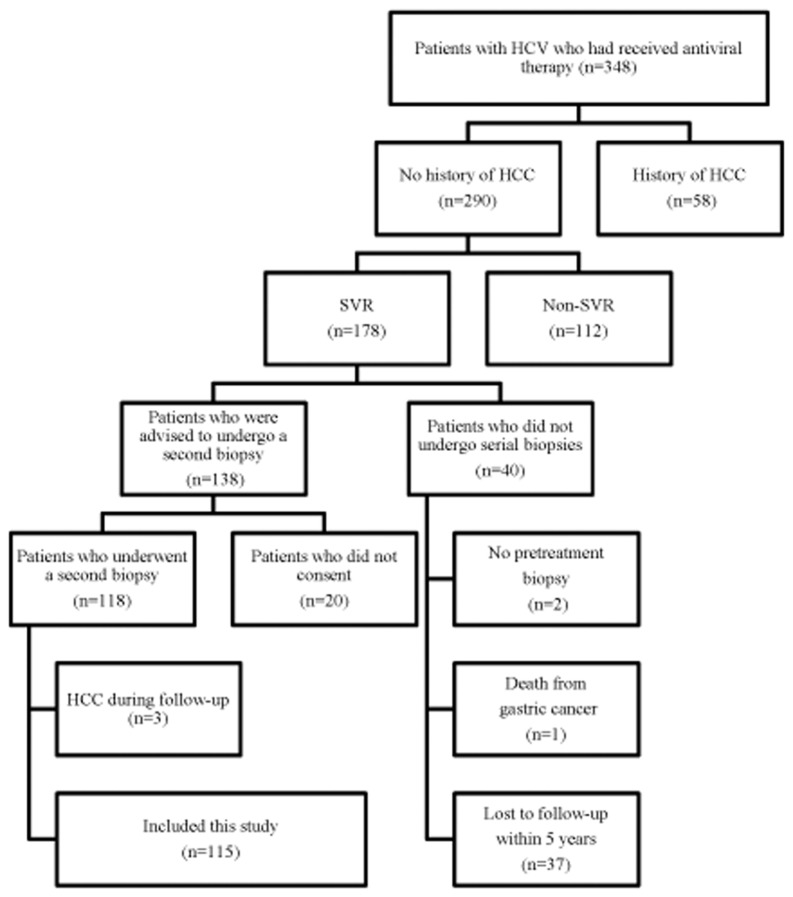
Study flow diagram.